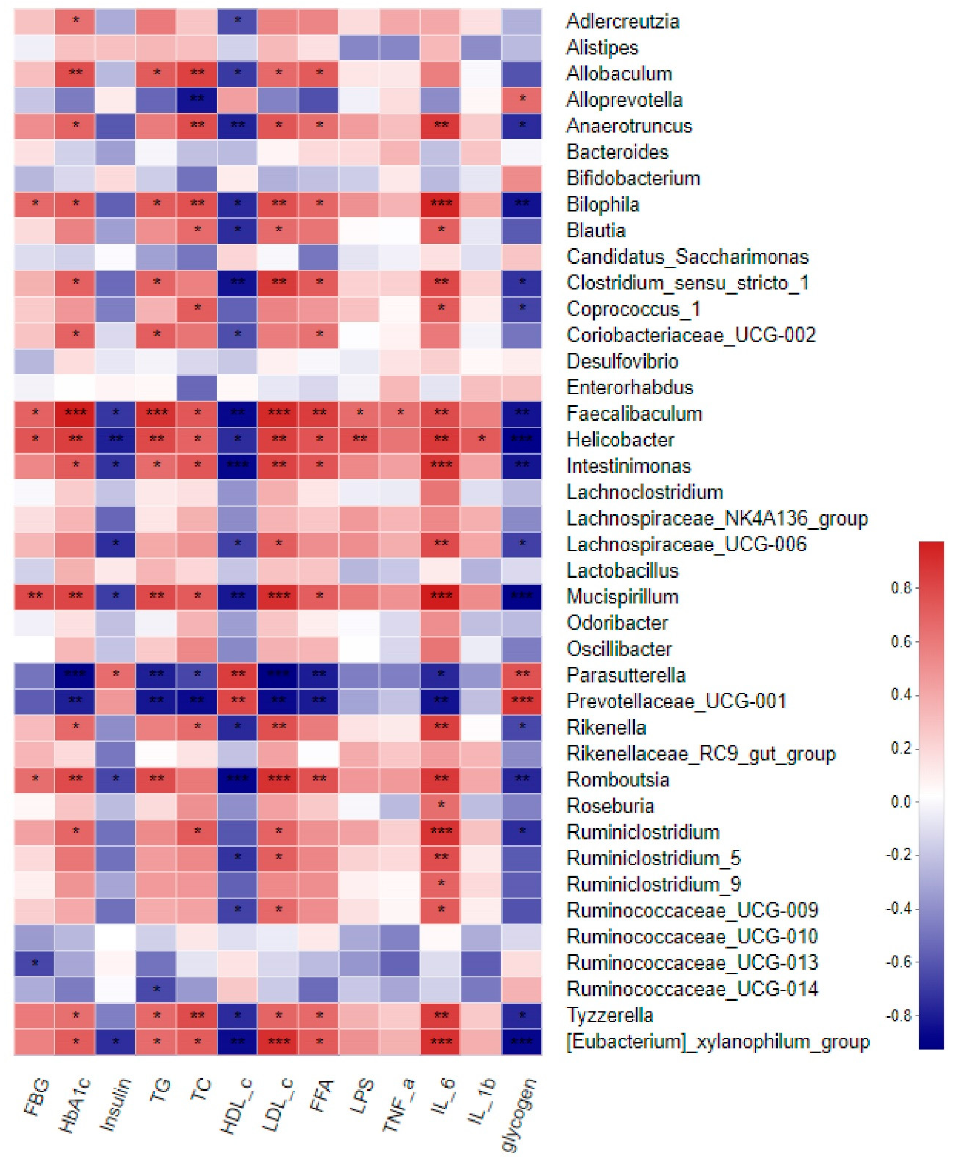
Figure 8. Heatmap of Spearman’s correlation between gut microbiota and T2D-related metabolic parameters. Red color represents a positive correlation, while blue color represents a negative correlation. * 0.01 < p ≤ 0.05, ** 0.001 < p ≤ 0.01, *** p ≤ 0.001.